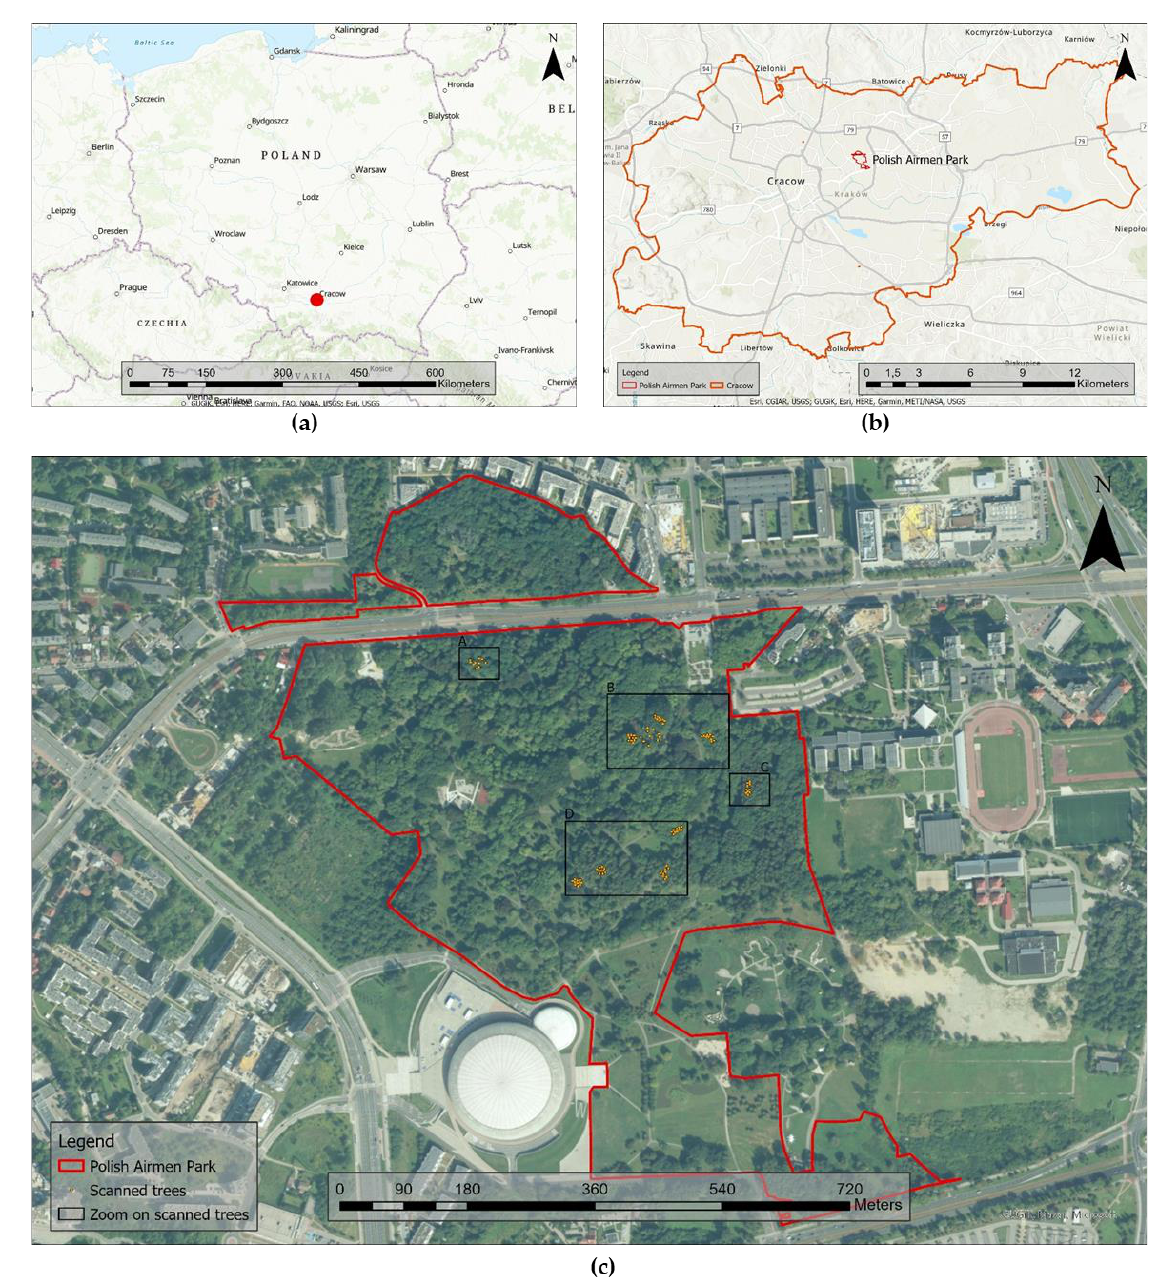
Figure 1. The study area: ( a ) overview map of Poland; ( b ) location of the Polish Airmen Park in Cracow; ( c ) the Polish Airmen Park in Cracow and the location of the scanned group of trees. The south part of the park is composed of different groups of tree species, either with or without shrubs or ornamental plants on the ground level. Among these